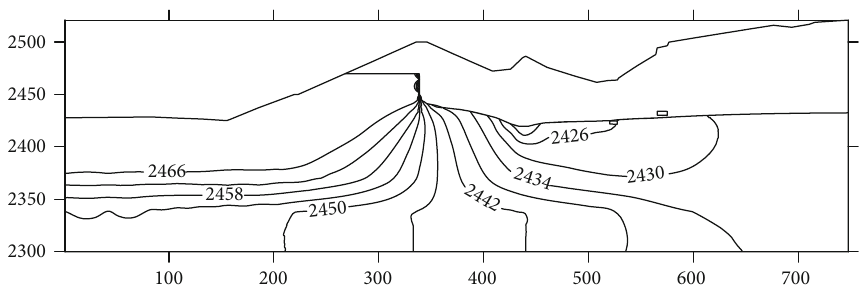
Figure 14: The isopotential distribution map of seepage fi eld about dam foundation (8-8 pro fi